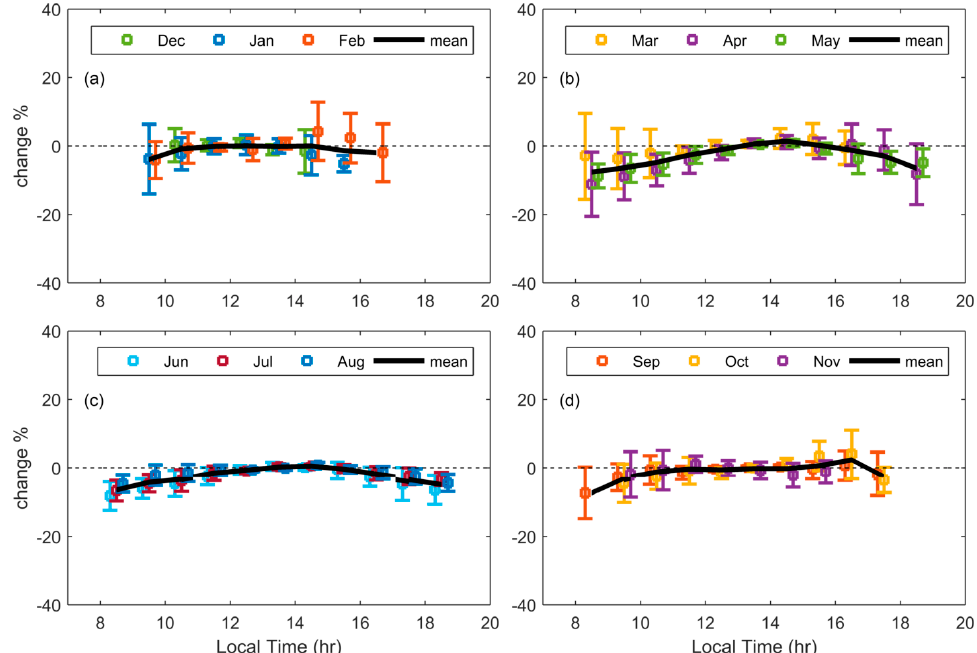
Figure 4. Average diurnal variability of the monthly mean SSA at 340 nm for ( a ) winter, ( b ) spring, ( c ) summer, and ( d ) autumn. The mean of the three months of each season is represented by the black thick line. Error bars represent the standard deviation for the monthly averages of each hourly value. Remote Sens. 2019 , 11 , x FOR PEER REVIEW